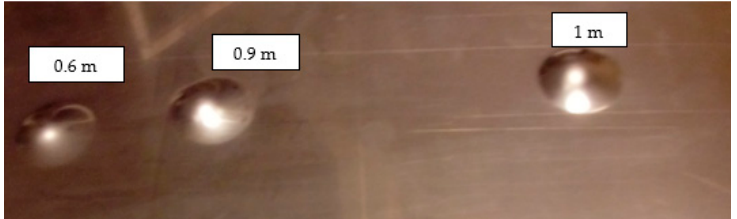
Figure 6. Tested metal sheet deformation after the impact of 1 kg weight from different heights: 0.6, 0.9, and 1.0 m.